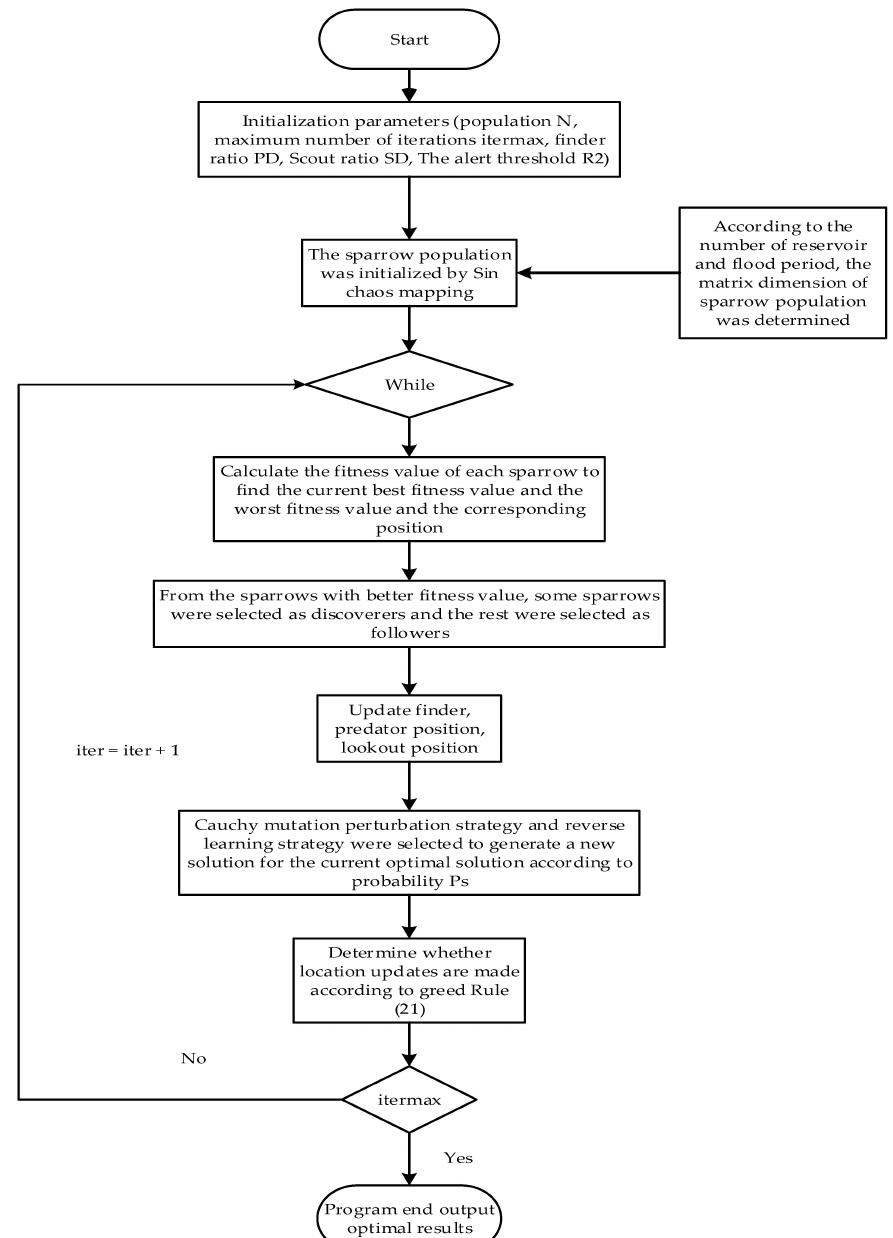
Figure 2. Flow chart of model calculation